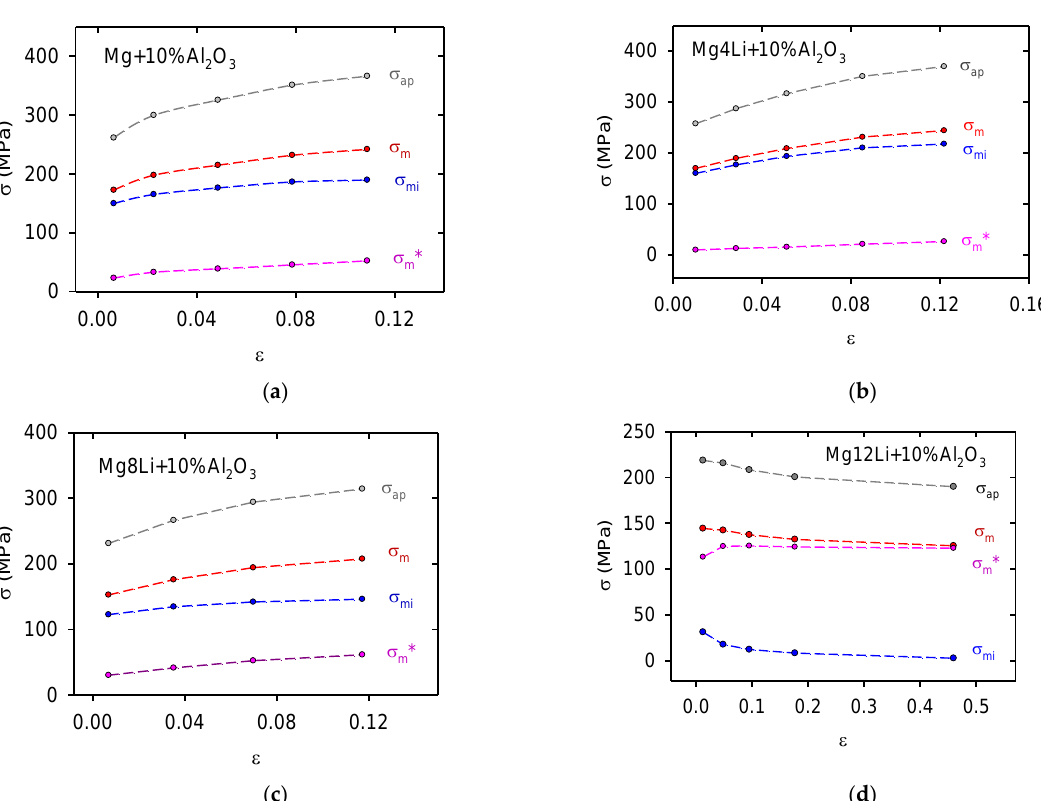
Figure 5. Strain dependences of the applied stress, σ ap ; matrix stress, σ m ; internal stress in the matrix, σ mi ; and the effective stress in the matrix, σ m *. The indicated points depict the SR tests. ( a ) Mg + 10%Al 2 O 3 , ( b ) Mg4Li + 10%Al 2 O 3 , ( c ) Mg8Li + 10%Al 2 O 3 , ( d ) Mg12Li + 10%Al 2 O 3